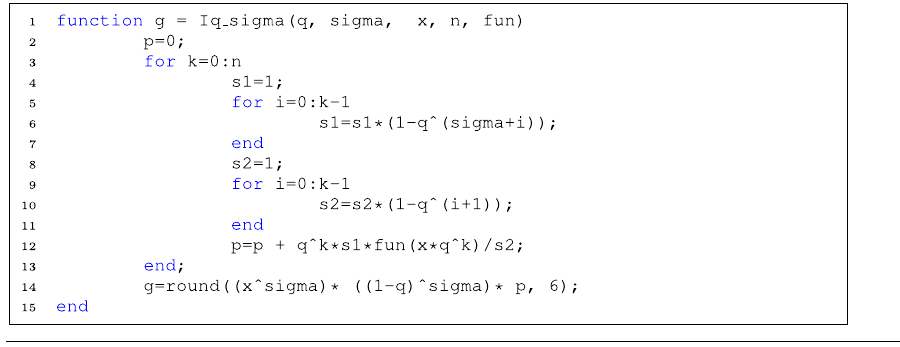
Algorithm 4 The proposed method for calculating I σ